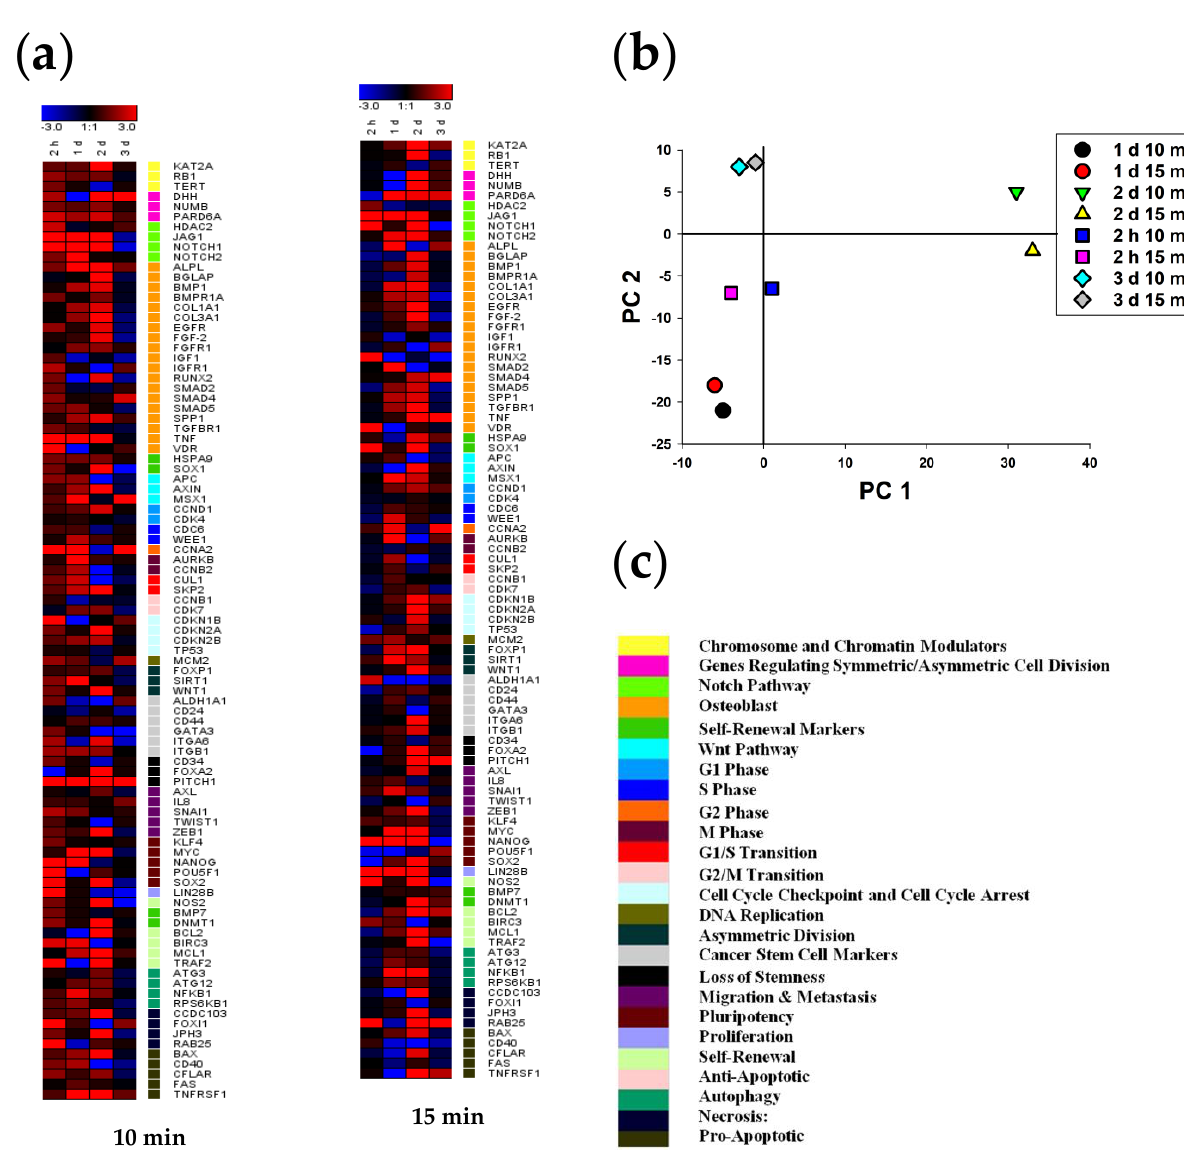
Figure 6. Heat map of gene expression in MSCs treated with 10 and 15 min CAAP irradiation after 2 h, 24 h, 48 h and 72 h of incubation (the deviations are shown in a logarithmic scale with a base of 2): ( a ) the intensity scale of the standardized expression values ranges from −3 (green: low expression) to +3 (red: high expression, with 1:1 intensity value (black) representing the control (nontreated); ( b ) principal component analysis (PCA) of qRT-PCR data for MSCs treated with 10 and 15 min CAAP irradiation after 2 h, 24 h, 48 h and 72 h; ( c ) cluster groups of genes and their functionality. The belonging of genes to different clusters and markers is shown using the color scale which is to the right of the diagrams. A validated database for gene ontology annotations is presented in Table S1.